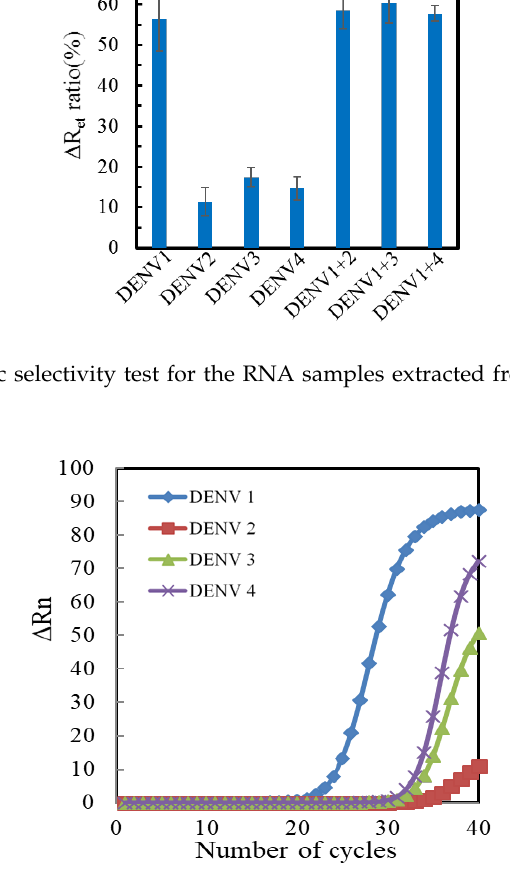
Table 3. Comparison of the Sensing Properties of Different Genosensors for the Detection of DENV.